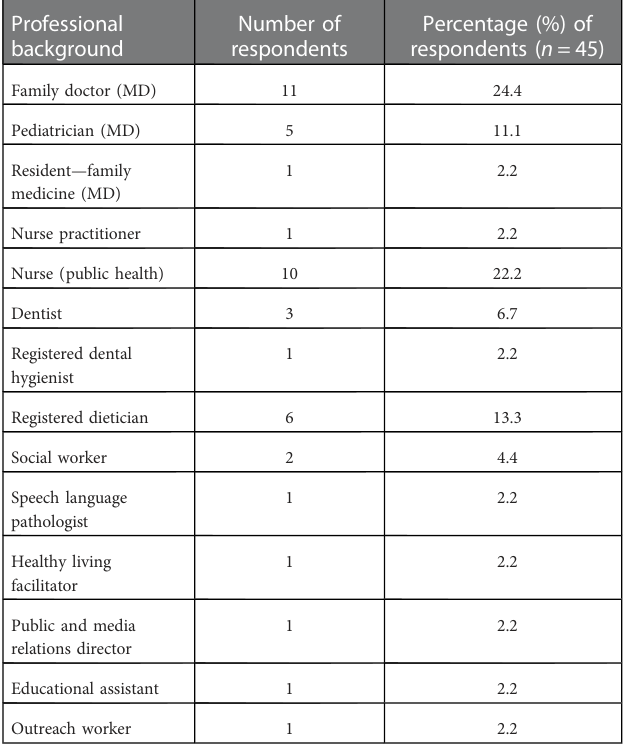
TABLE 2 Survey respondents ’ professional